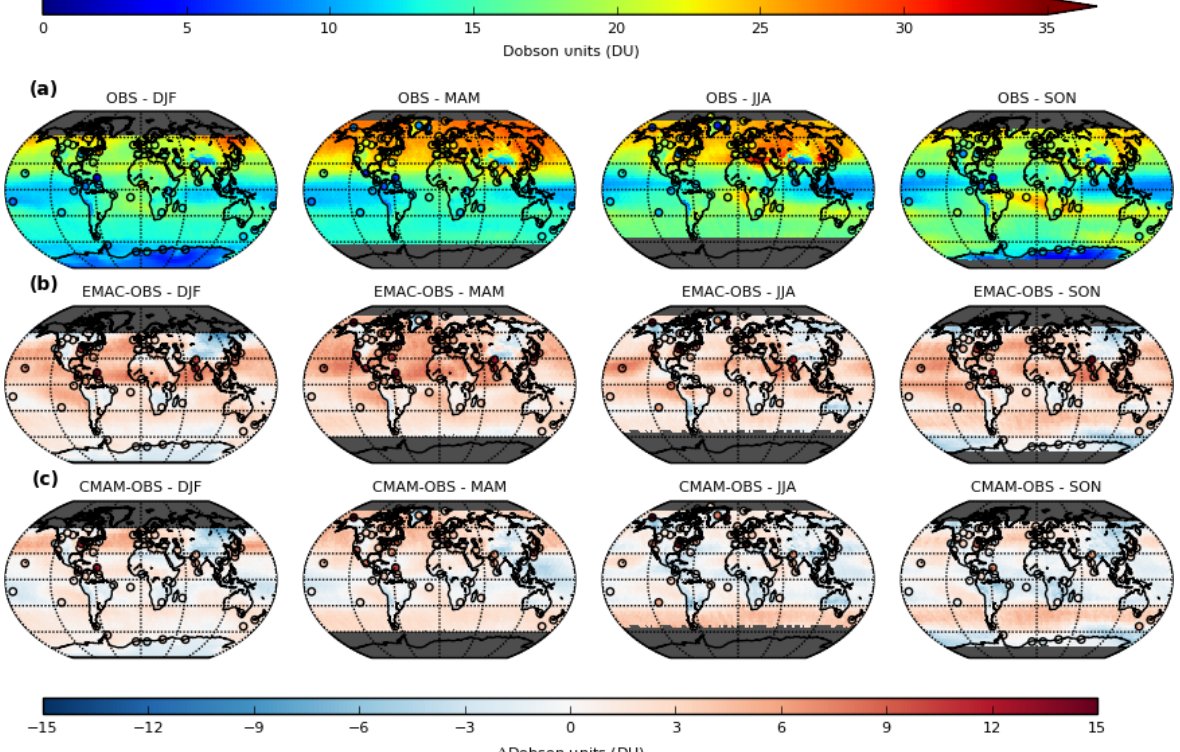
Figure 1. Seasonal composites of monthly averaged 1000–450hPa (0–5.5km) sub-column O 3 (DU) (left to right) for 2005–2010 from (a) OMI, (b) EMAC minus OMI and (c) CMAM minus OMI. Circles denote (a) equivalent ozone-sonde-derived sub-column O 3 (DU), (b) EMAC minus ozone-sonde differences and (c) CMAM minus ozone-sonde differences. All data were regridded to 2.5 ◦ resolution ( ∼ 275km). All model and ozone-sonde sub-column data have been modified using AKs to ensure a direct